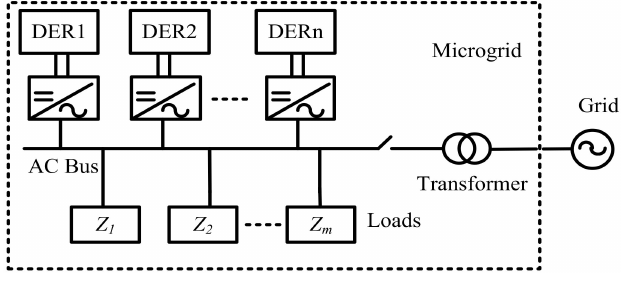
Figure 1. Simplified microgrid structure.